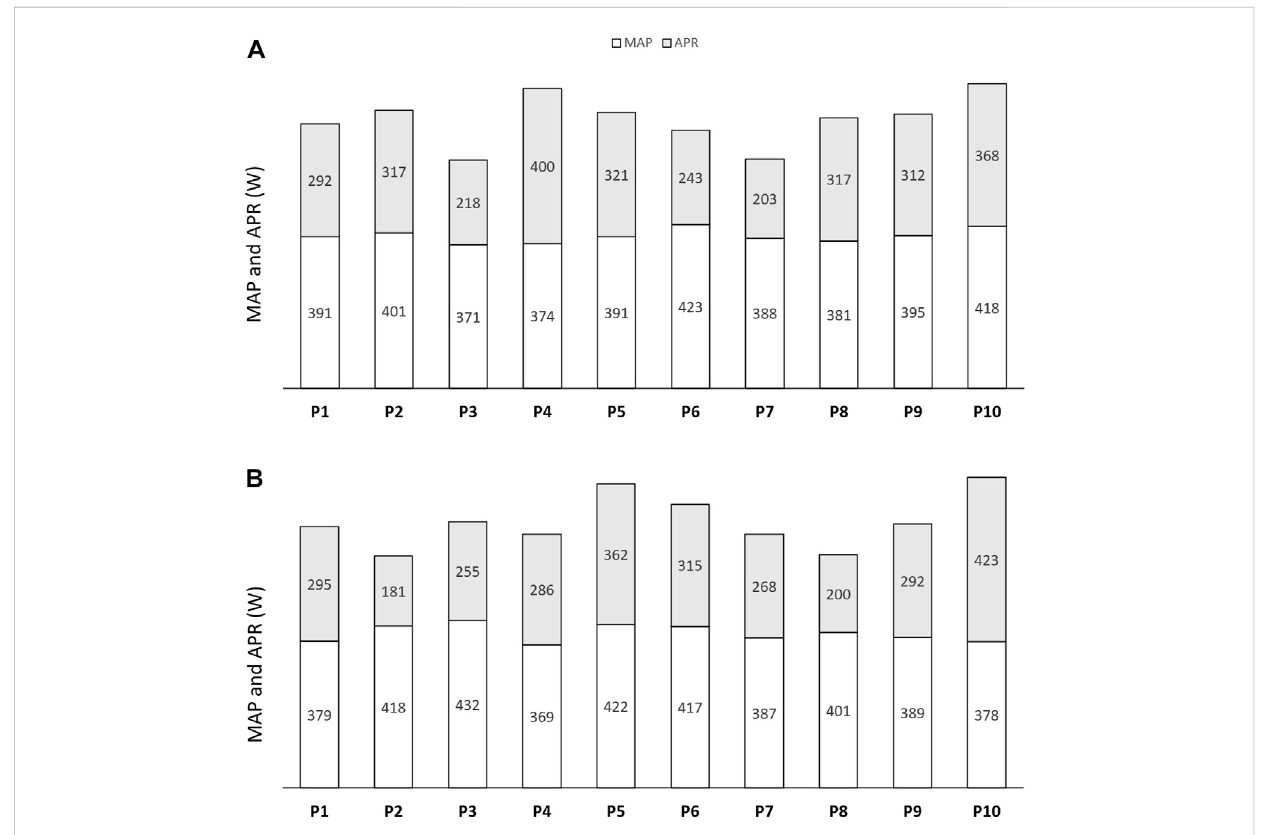
FIGURE 3 Individual values of maximal aerobic power (MAP) and anaerobic power reserve (APR) in (A) APR Δ %30 group and (B) MAP 130% group at the baseline.